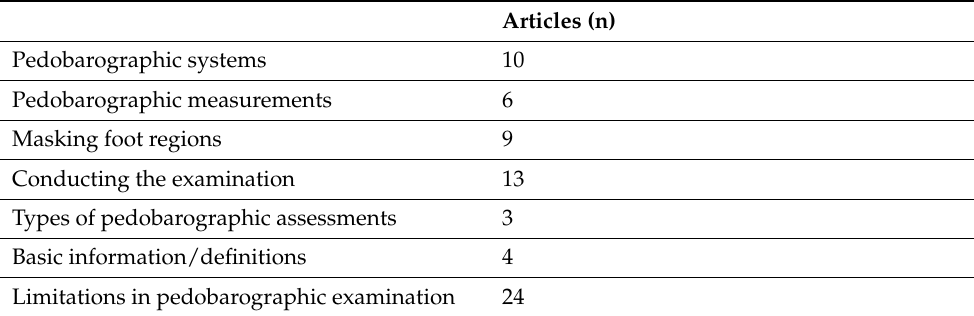
Table 1. Main topics covered in pedobarography-related articles